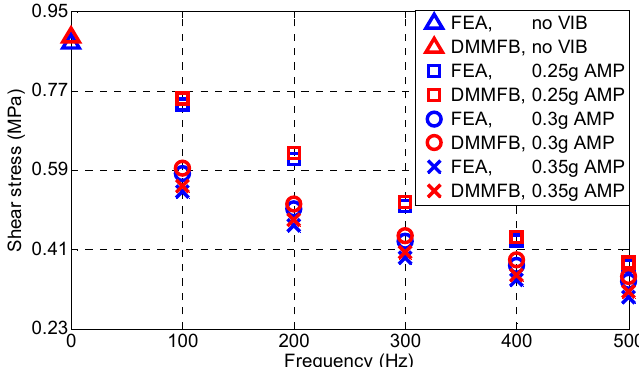
Figure 11. Effective value of the shear stress without and with different-amplitude vibration applied. Figure 11. E ff ective value of the shear stress without and with di ff erent-amplitude vibration applied.